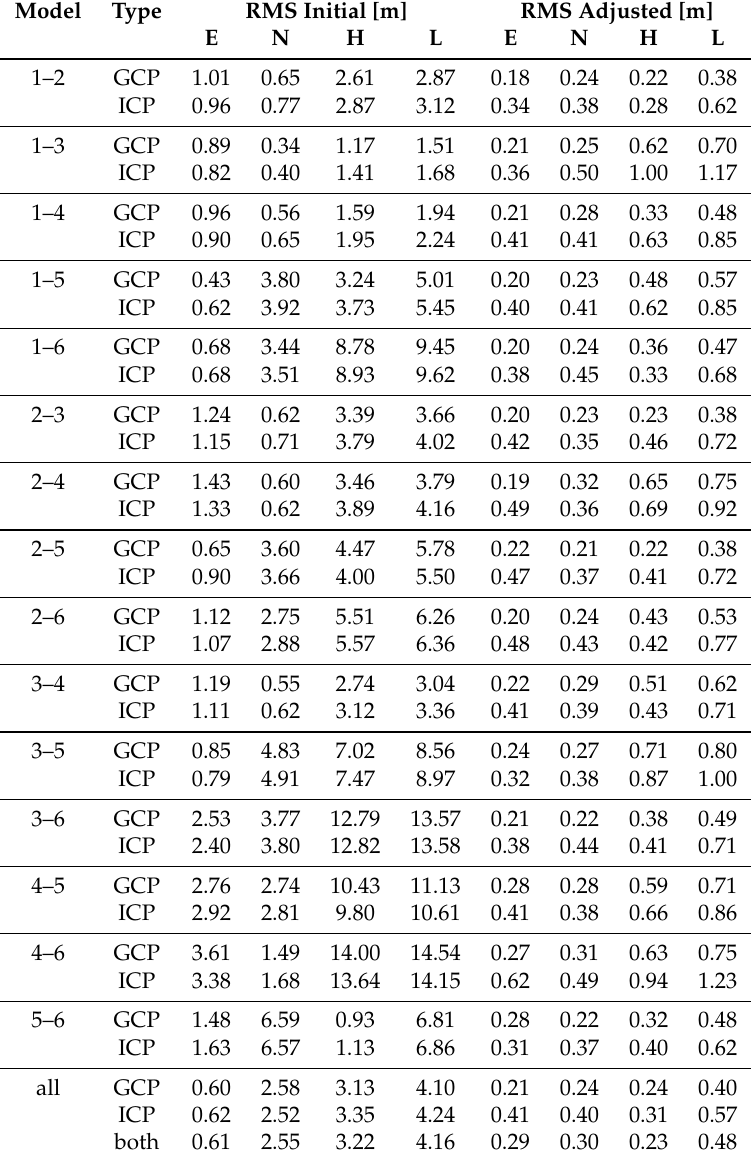
Table 8. 3D RMS residuals using GCPs and ICPs for the Ljubljana test set given in meters. The adjustment is based on GCPs and evaluated on GCPs and ICPs. Values are given for East (E), North (N), Height (H) and their 3D Length